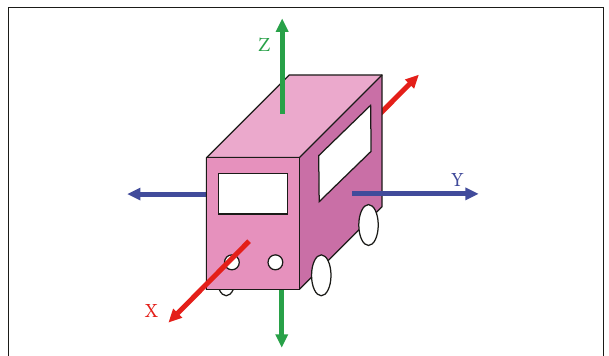
Figure 5: Vehicle movement represented in a coordinate system.